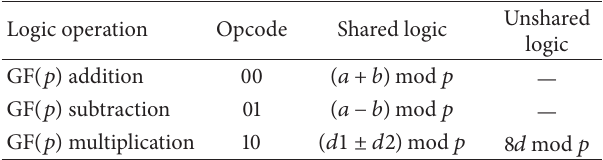
Table 1: Operation codes for unified Add/Sub/Mul